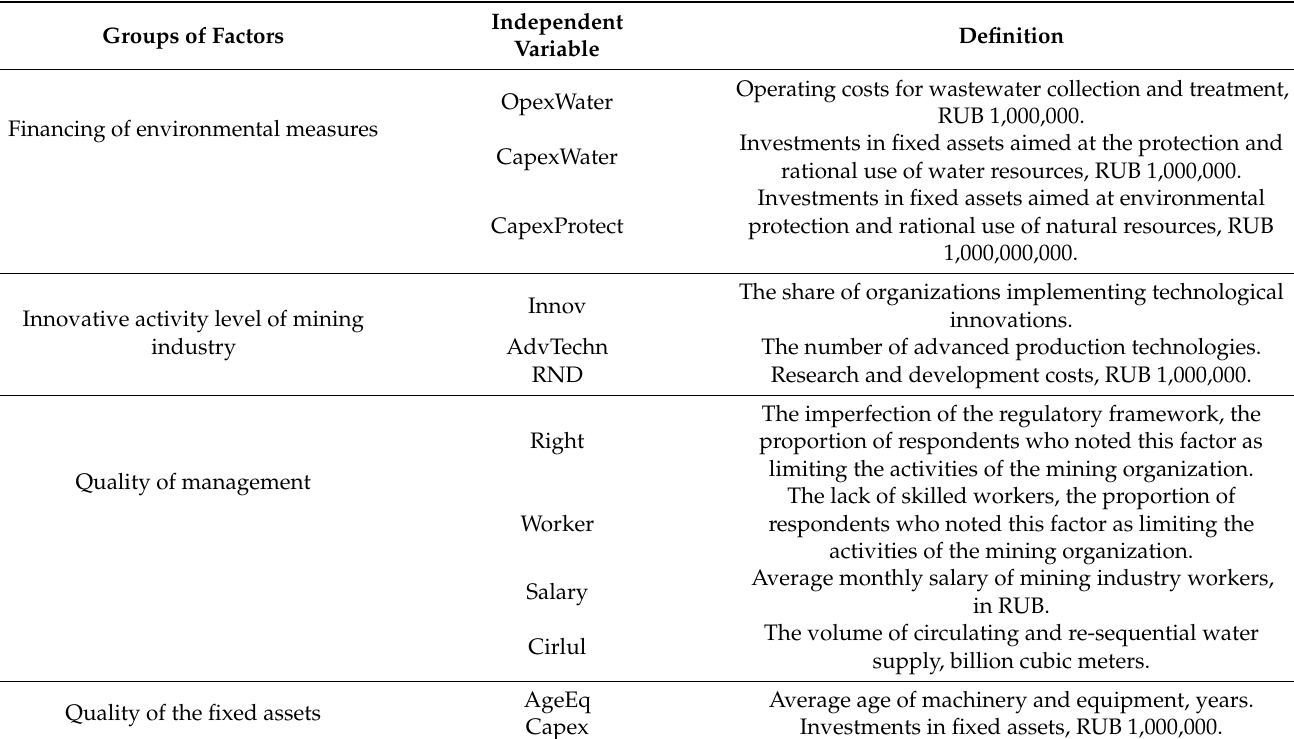
Table 4. Description of the independent variables.